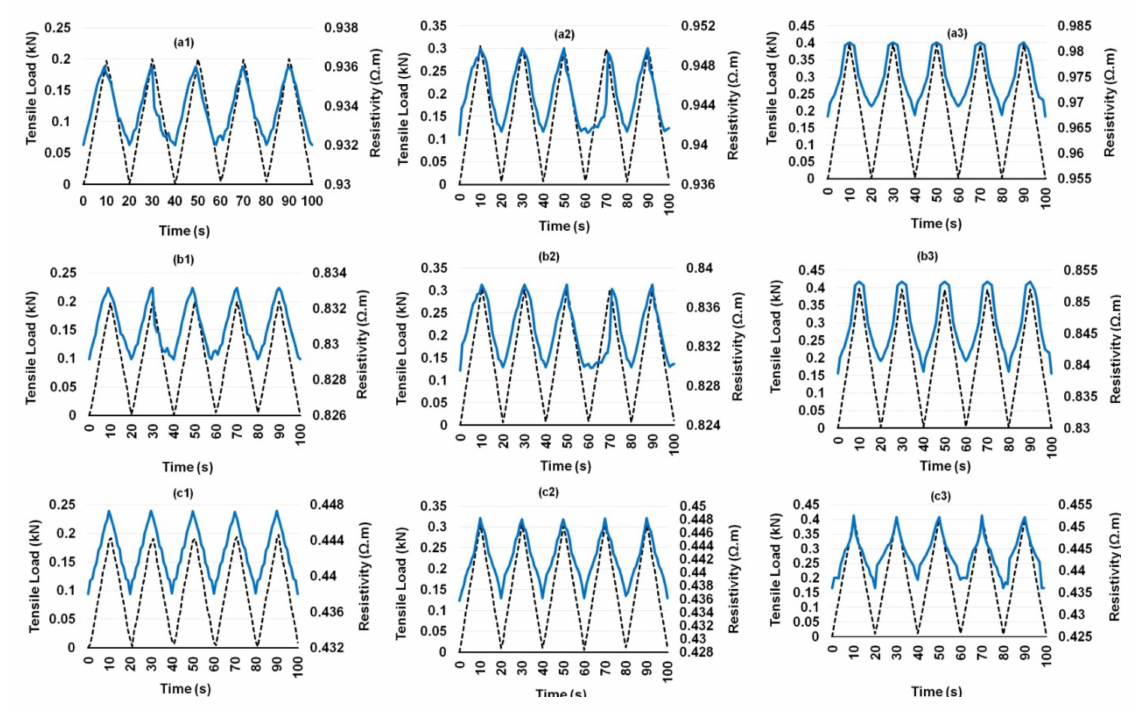
Figure 11. Change of electrical resistance with cyclic tensile load of 0.15% CNF-reinforced cementi- tious composites at different peak loads containing 0.25% CF ( a1 – a3 ), 0.50% CF ( b1 – b3 ) and 0.75% CF ( c1 – c3 ).